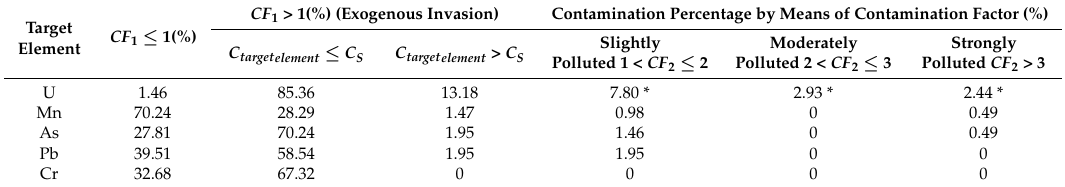
Table 2. The results of target element contaminations by means of contamination